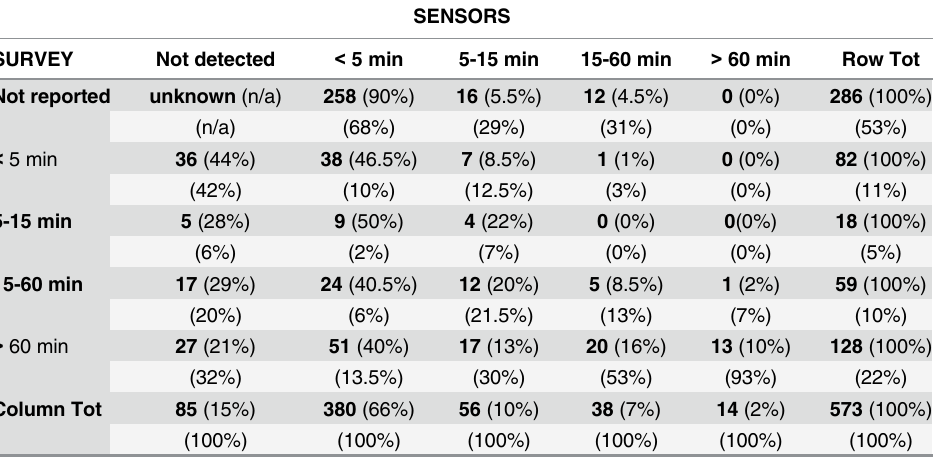
Table 4. Sensors vs. contact diaries: cross-tabulation of the number of links in each duration cate- gory. The percentages within a cell are computed with respect to the row (right of the cell entry) and column (below the cell entry)